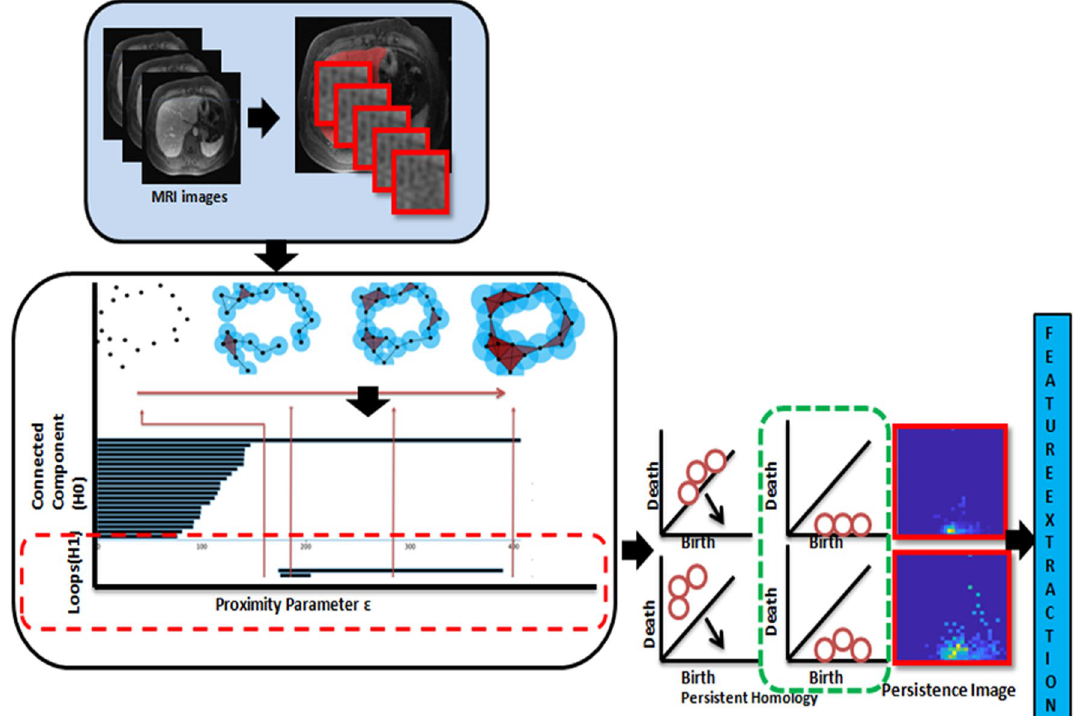
Fig. 6 Workflow of algebraic topology-based machine learning with MRI imaging signal as